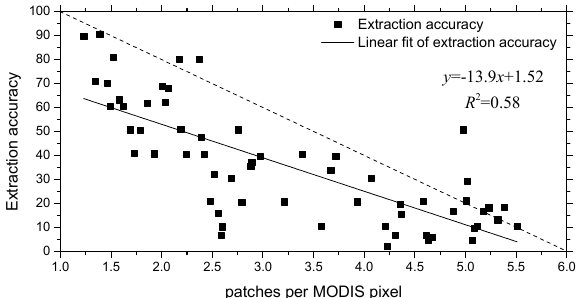
Figure 10. Decreasing trends of extraction accuracy when the patches per MODIS pixel are increased, which denotes a greater heterogeneity of the land cover.